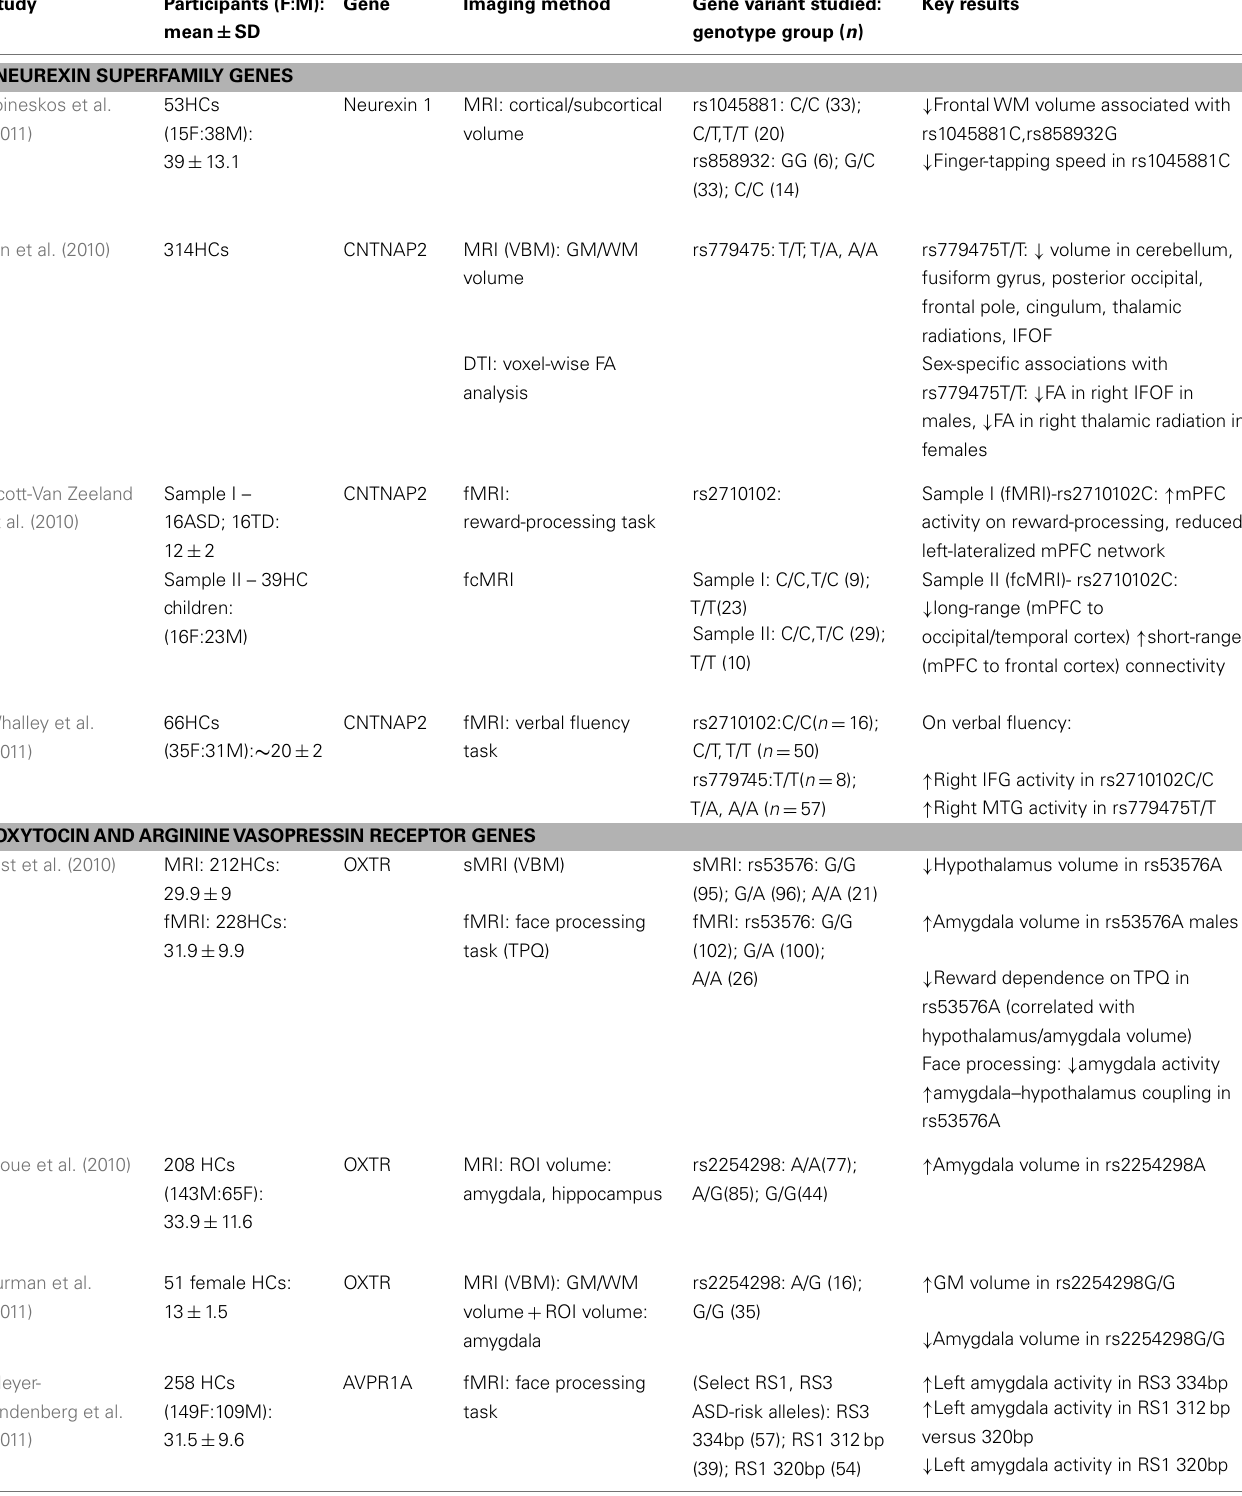
Table 1 | Imaging-genetics studies using the intermediate phenotype approach to examine the neural effects ofASD-related risk genes.